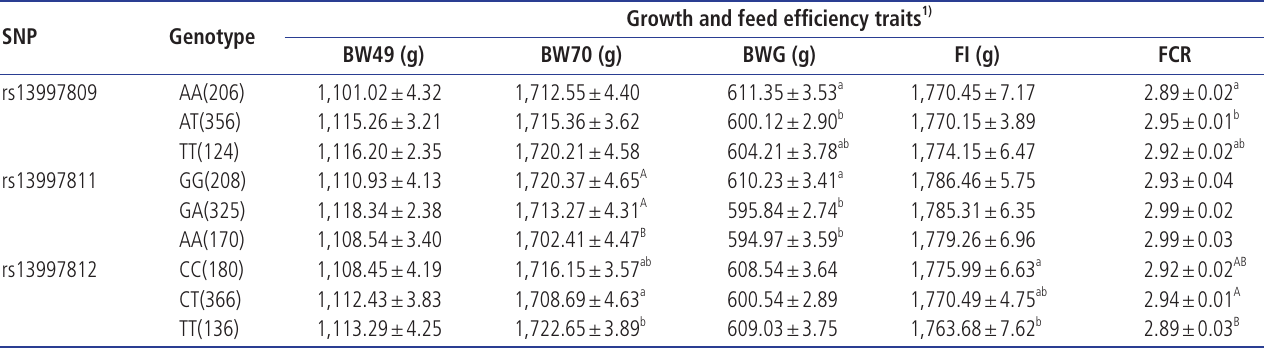
Table 6. Least squares means±SE for growth and feed efficiency traits among genotypes of three SNPs in the UCP3 gene in meat-type chickens SNP